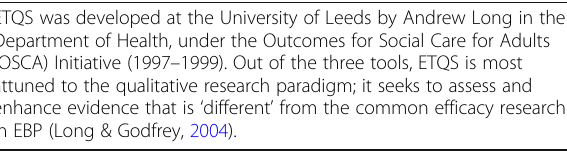
Table 8 ETQS (Evaluation Tool for Qualitative Studies) ETQS was developed at the University of Leeds by Andrew Long in the Department of Health, under the Outcomes for Social Care for Adults (OSCA) Initiative (1997 – 1999). Out of the three tools, ETQS is most attuned to the qualitative research paradigm; it seeks to assess and enhance evidence that is ‘ different ’ from the common efficacy research in EBP (Long & Godfrey,